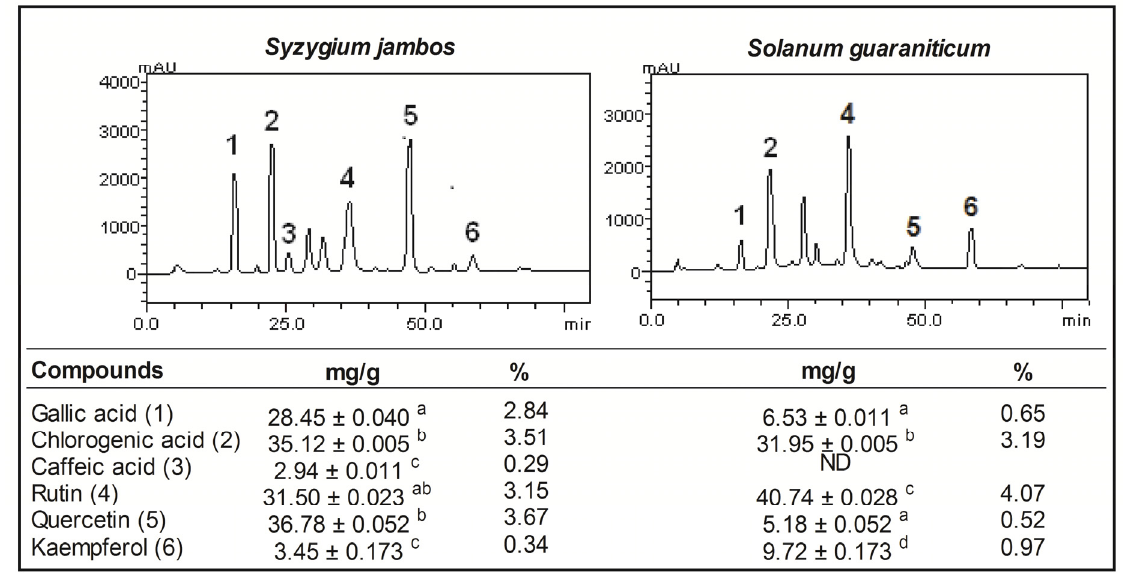
Figure 1. HPLC/DAD profile of extracts tested (detection UV at 271 nm) and quantification of phenolic compounds found [Gallic acid (peak 1), chlorogenic acid (peak 2), caffeic acid (peak 3), rutin (peak 4), quercetin (peak 5) and kaempferol (peak 6). Quantification results are expressed as mean ± SEM ( n = 3) assessed by one way ANOVA followed by Duncan Multiple Comparison post hoc test. Means marked with different letters are significantly different ( p < 0.05). ND = not